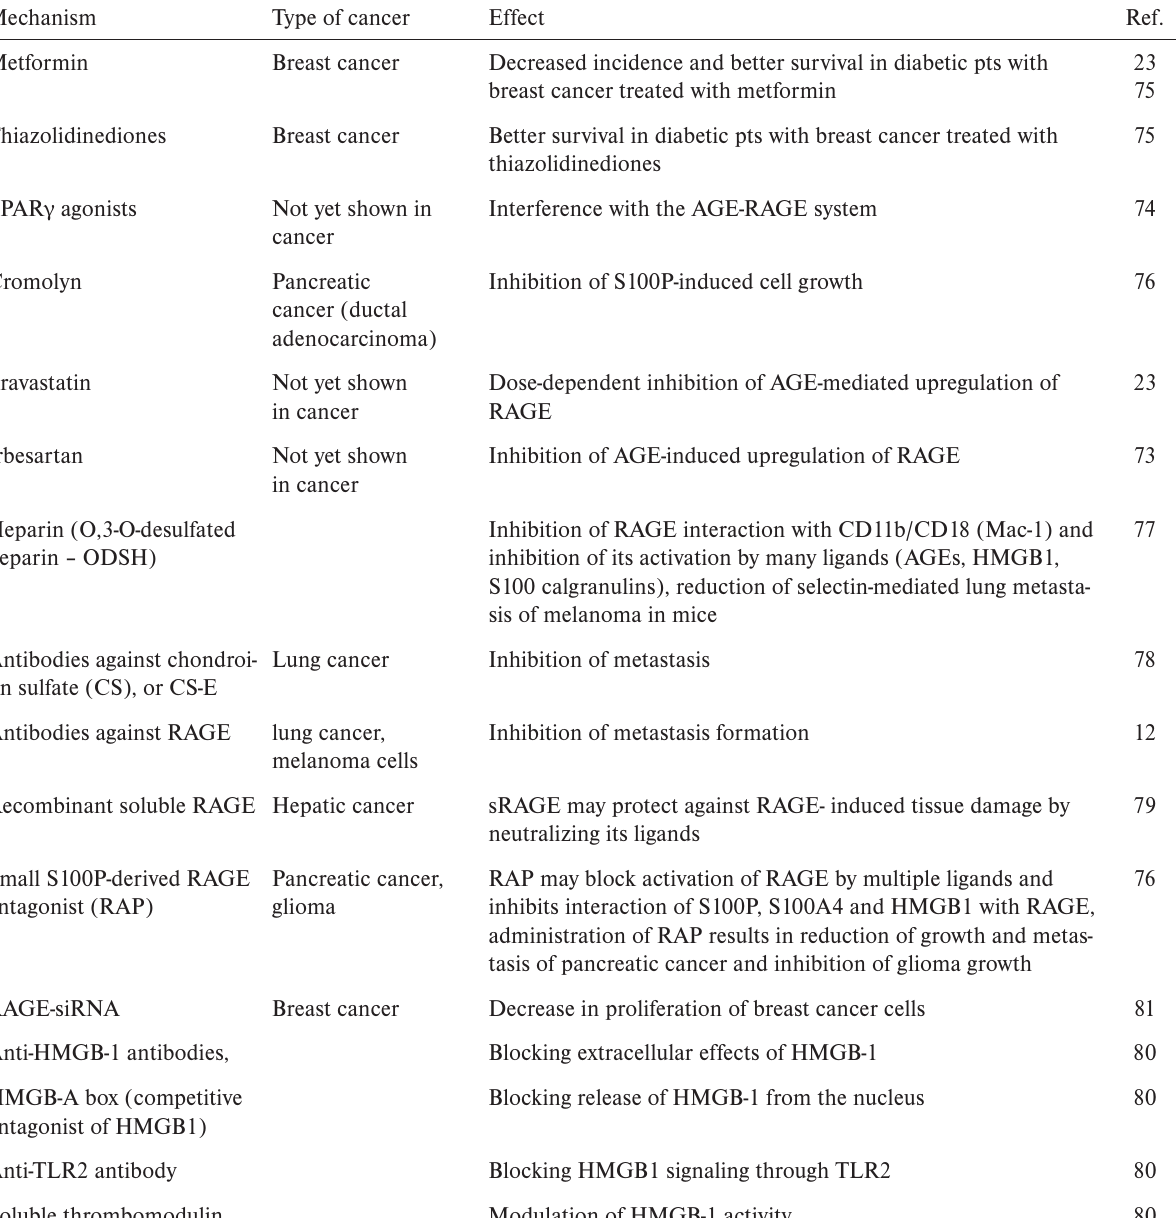
Table 2. Putative interference with RAGE ligands and RAGE-mediated effect. Mechanism Type of cancer Effect